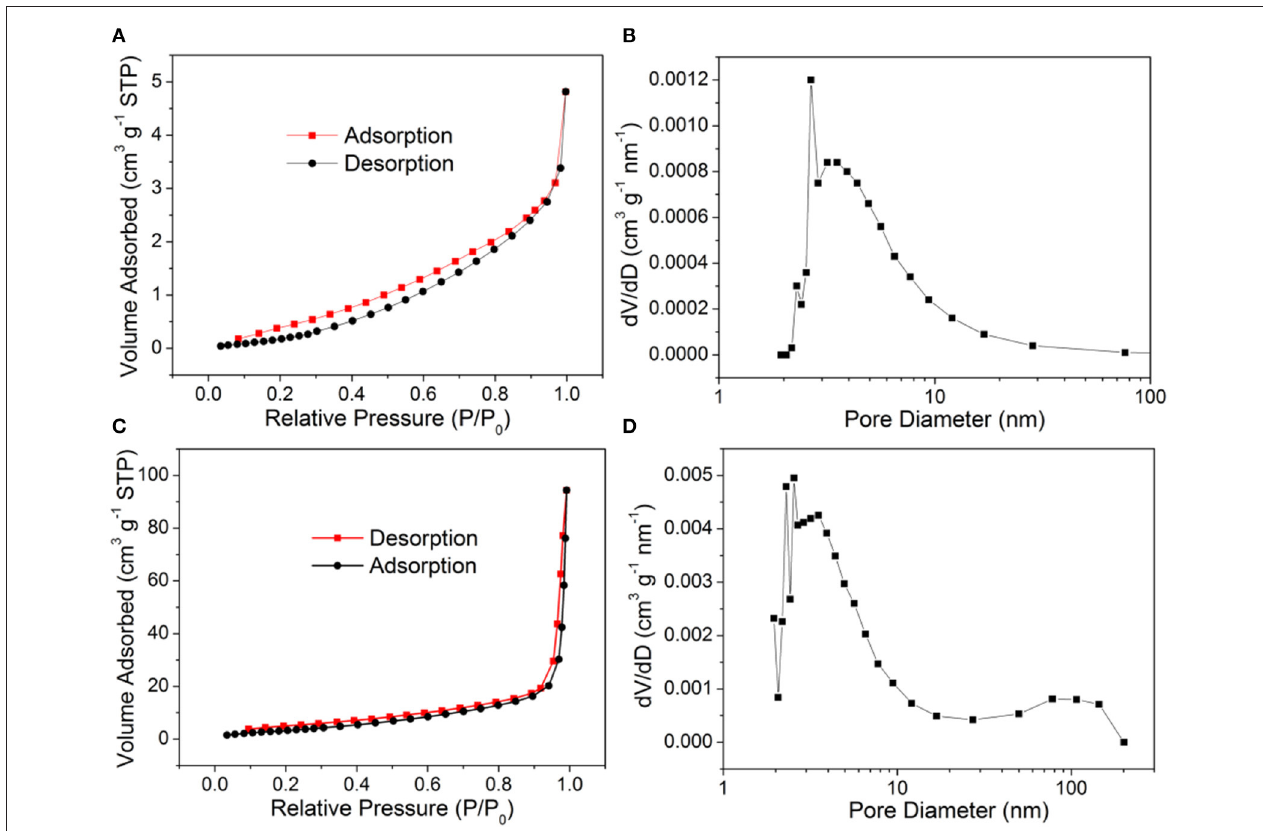
FIGURE 10 | (A,C) N 2 adsorption–desorption isotherms and (B,D) pore size distribution plots of (A,B) commercial Cu 2 O powder, and (C,D) 119-nm Au@Cu x O core–shell